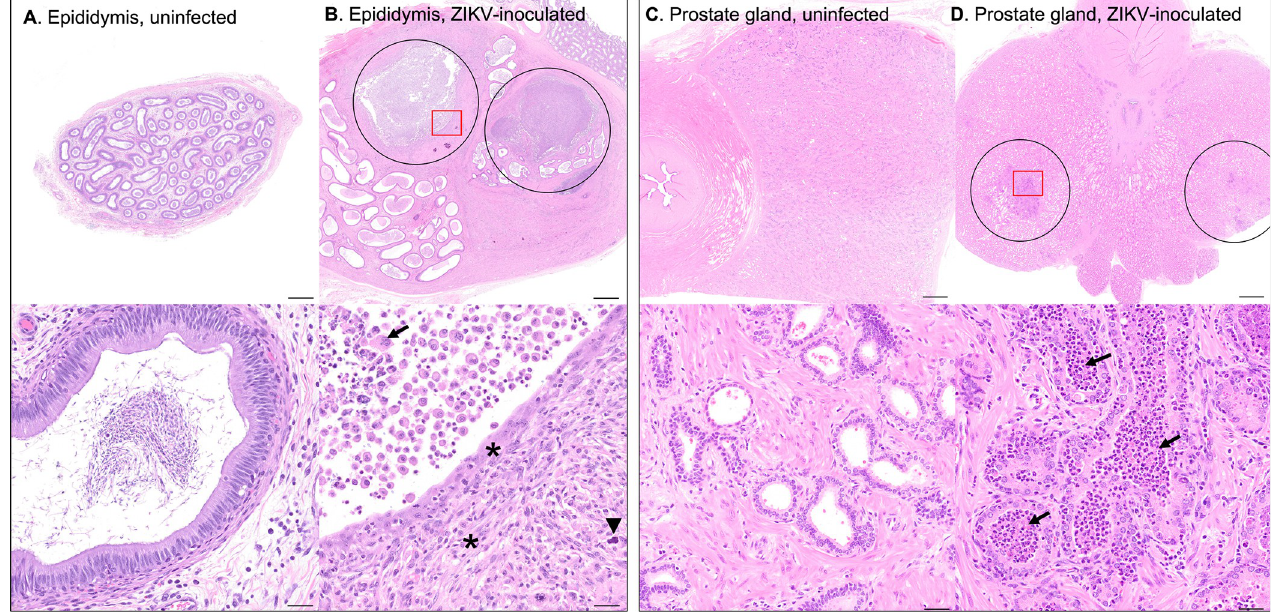
Fig 6. Photomicrographs of H&E-stained genital tissues from uninfected & ZIKV-inoculated male rhesus macaques. A.) Normal epididymis from an uninfected control animal. B.) Epididymis from a ZIKV-inoculated rhesus macaque with duct rupture and pyogranulomatous epididymitis (circled). Remaining epididymal ducts are dilated and tortuous with sperm stasis. In the 20X image (lower panel, area denoted by red box in upper panel) normal duct epithelial architecture is lost with replacement by fibroplasia (asterisks) and mineralization (arrowhead) with neutrophils, multinucleated giant cells (arrow), and necrotic debris. This correlates with virology data, where macaques with detectable epididymal ZIKV RNA exhibited higher histology scores than those without detectable virus (linear model, p = 0.008). C.) Normal prostate gland from an uninfected control animal. D.) Prostate gland from a ZIKV-inoculated macaque with mild to moderate prostatitis (circled). In the 20X image (lower panel, area denoted by red box in upper panel) glandular lumens are expanded or replaced by sloughed cells, necrotic debris, neutrophils, and macrophages (arrows). Scale bars: upper images 1mm; lower images 20 μ m.